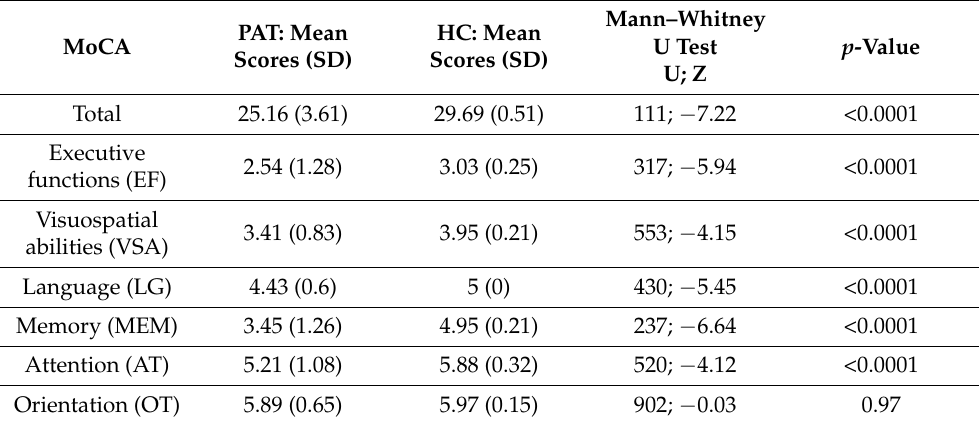
Table 3. MoCA scores of the PAT